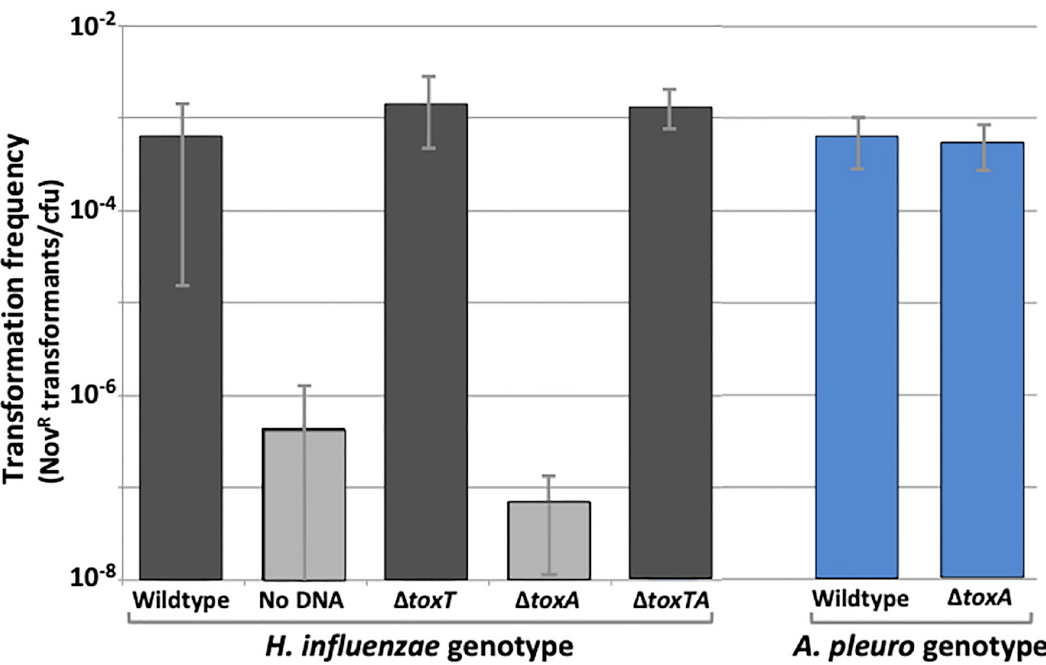
Fig 2. Transformation phenotypes of wildtype cells and toxTA mutants. Competence-induced cultures were incubated with MAP7 chromosomal DNA, and transformation frequencies were calculated as the novobiocin resistant (Nov R ) colonies per colony forming unit (CFU). Bars represent the means of at least three biological replicates, with error bars representing one standard deviation. Grey bars indicate values below the detection limit (~10 − 8